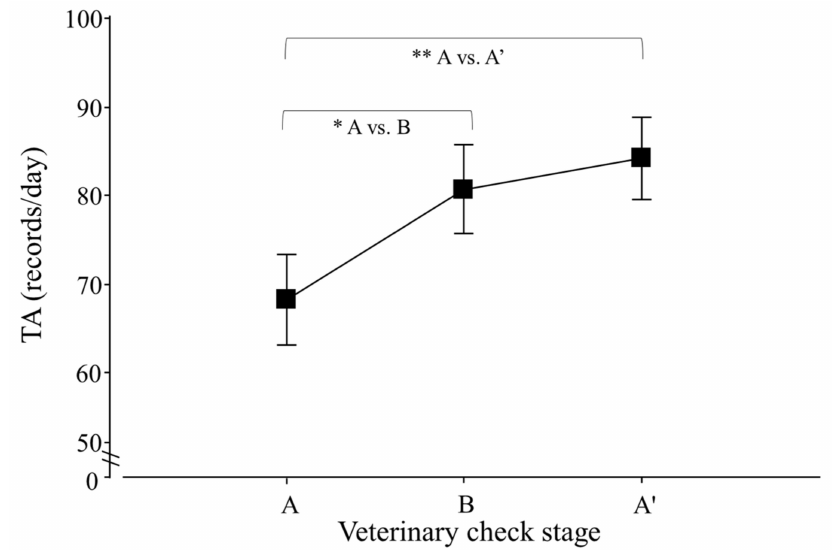
Figure 4. Total activity (TA) per day of adult Tamandua tetradactyla ( n = 3 females and 3 males) exposed to semi-controlled conditions, in response to veterinary check (applied in B) during winter and summer. Data from winter and summer were pooled because there was no effect of season. The ABA experimental design applied: day 0 (previous-stage A), days 1 and 2 (disturbance—stage B) and day 3 (posterior-stage A (cid:48) ). Behaviour was recorded every 5 min (288 records/day/individual), and the number of activity records per day during each stage was calculated. Asterisks indicate significant differences between stages for all individuals ( p values in the text). Results are expressed as the mean ±